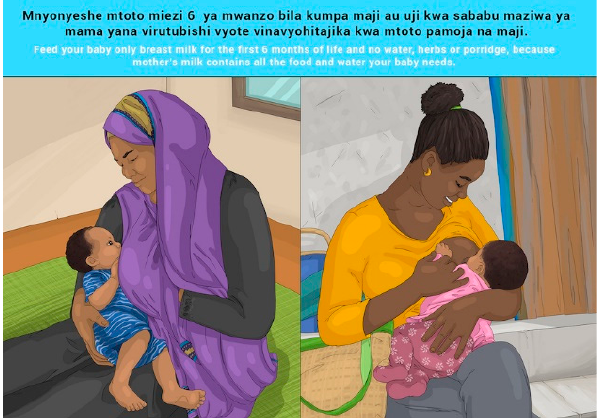
Figure 11. Feed your baby only breast milk for the first 6 months of life and no water, herbs or porridge, because mother’s milk contains all the food and water your baby needs.